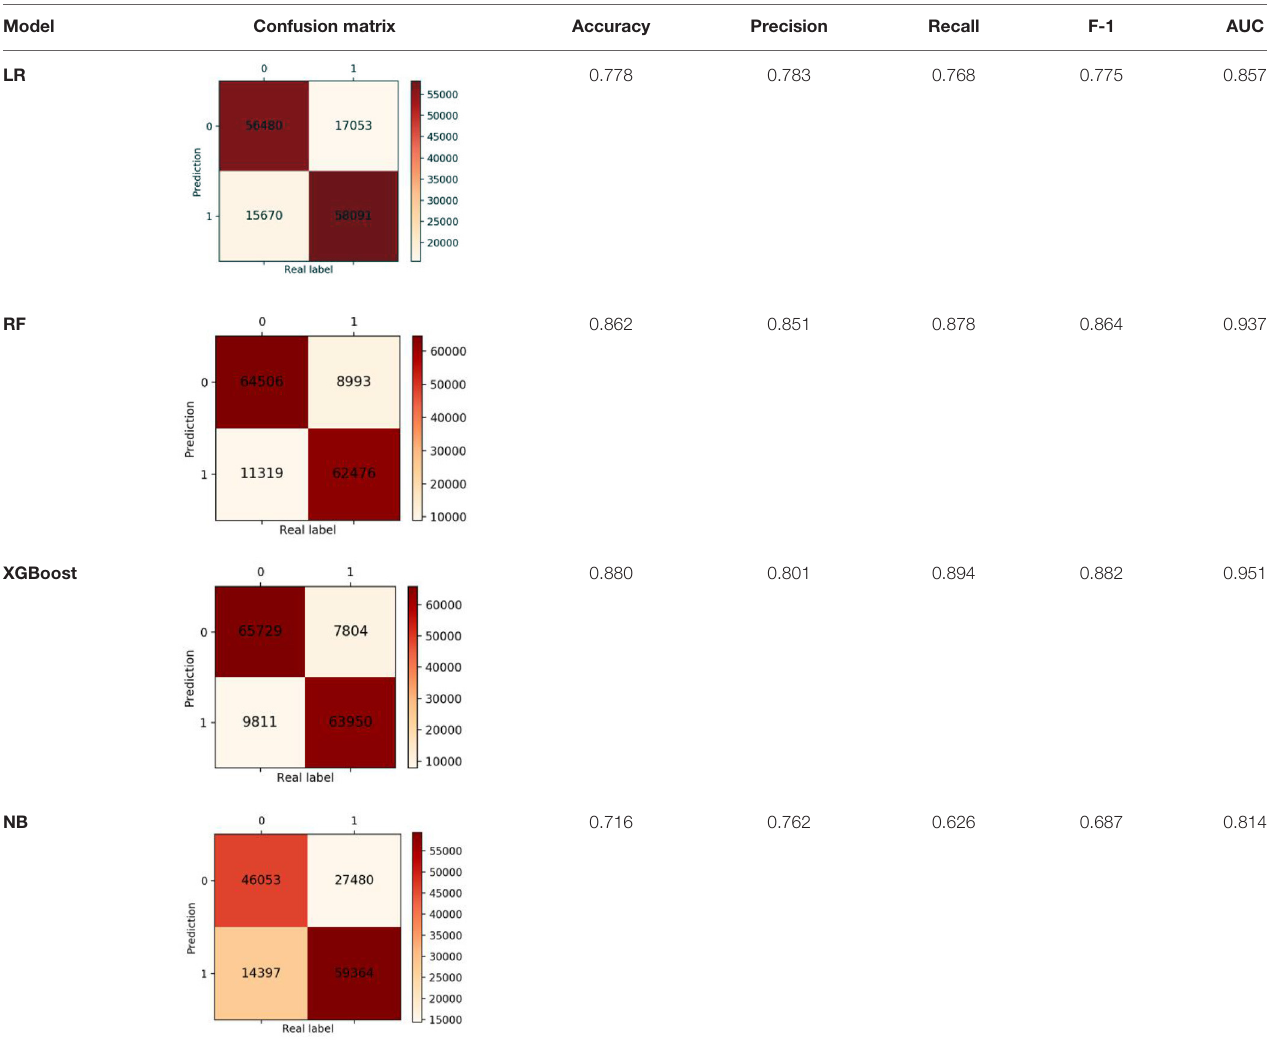
TABLE 3 | The results of classification